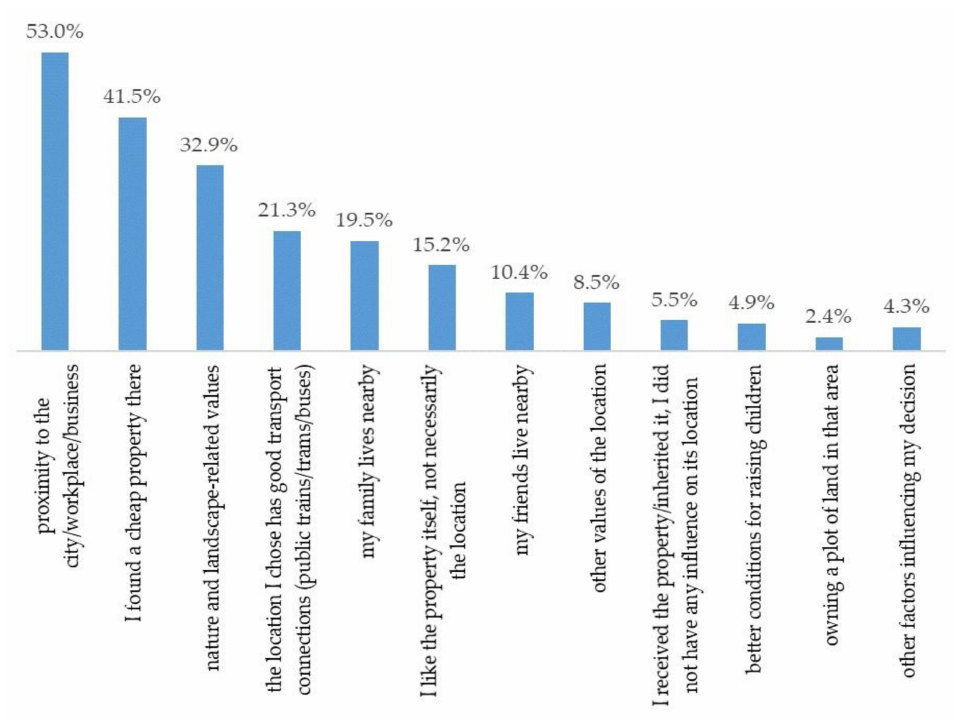
Figure 4. Reasons for choosing a specific location (village). Source: own study based on research results. Environmental considerations, which were crucial for choosing the direction, were less frequently indicated. The most common answer was the natural and landscape values indi- cated by every third (32.9%) respondent. A significant portion of the respondents also chose the following answers: family lives nearby (19.5%) and/or friends live nearby (10.4%). A share of 15.2% of the respondents chose the answer—I liked the property